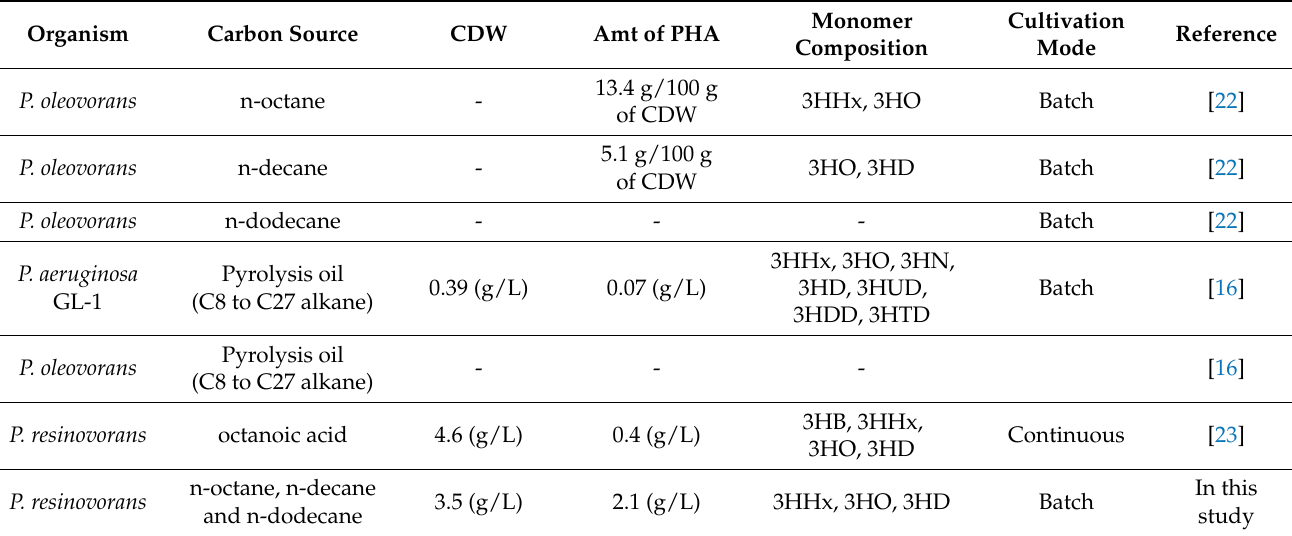
Table 3. mcl-PHA production using various alkanes by Pseudomonas